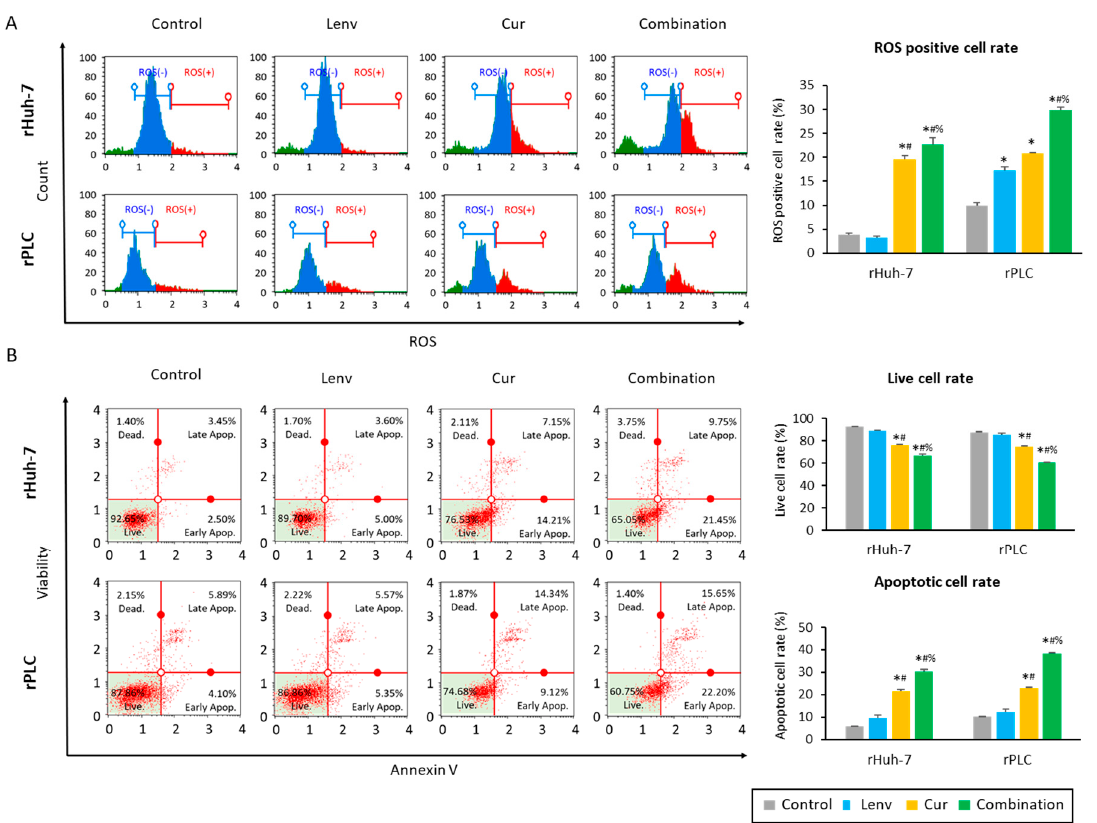
Figure 4. Co-administration of Curcumin with Lenvatinib induced cellular apoptosis via intracellular accumulation of ROS. ( A ) Representative images of oxidase stress assay following treatment in Lenvatinib-resistant cells (*: p < 0.05 vs. control, #: p < 0.05 vs. Lenvatinib, %: p < 0.05 vs. Curcumin). ( B ) Representative images of annexin-V assays. Graphs indicate the percentages of live and apoptotic cells (*: p < 0.05 vs. control, #: p < 0.05 vs. Lenvatinib, %: p < 0.05 vs. Curcumin). The data indicate mean (column) ± SD values. ROS, reactive oxygen species; SD, standard deviation.